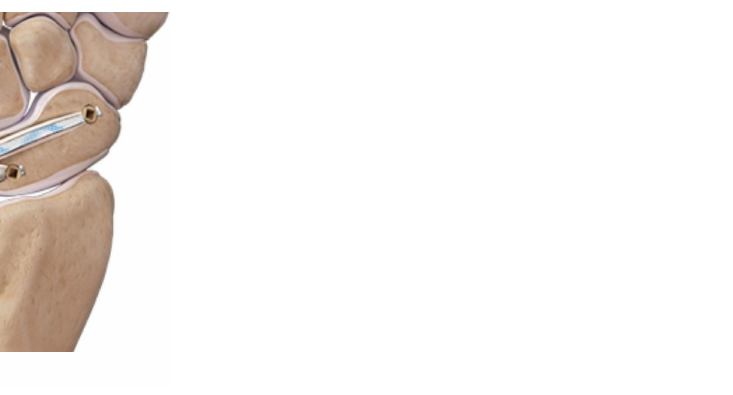
Figure 3. Schematic diagrams of the three different reconstructions. Short-transverse internal bracing (IB) ( a ), long-oblique IB ( b ), and Combo IB ( c ). This image was provided courtesy of Arthrex, Naples, Florida, 2021.